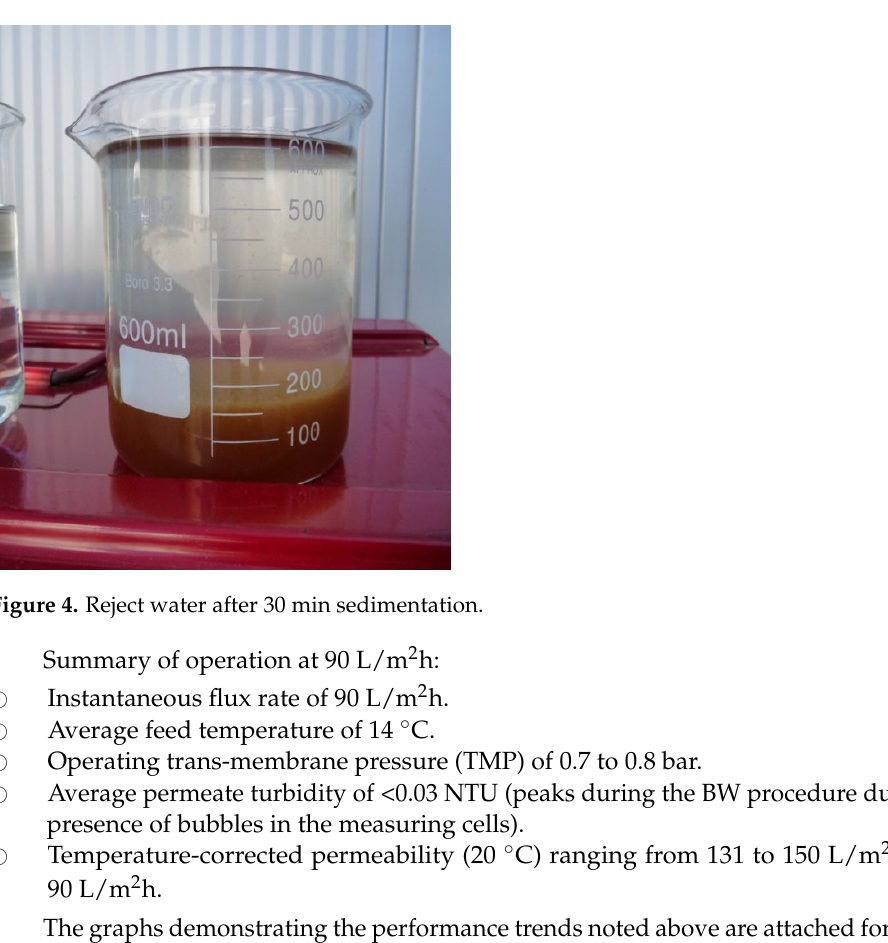
Figure 3. Feed, permeate, and reject water.